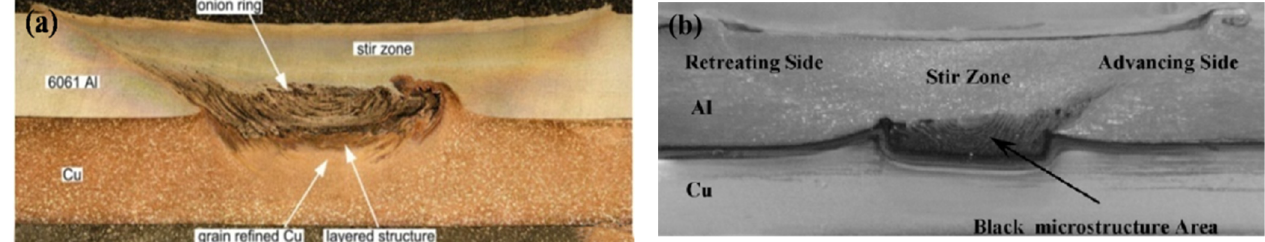
Figure 10. Macroscopic morphology of Cu–Al FSW lap joint: ( a ) (adapted from [72], with permission from Springer, 2011); ( b ) (adapted from [71], with permission from Elsevier, 2007).